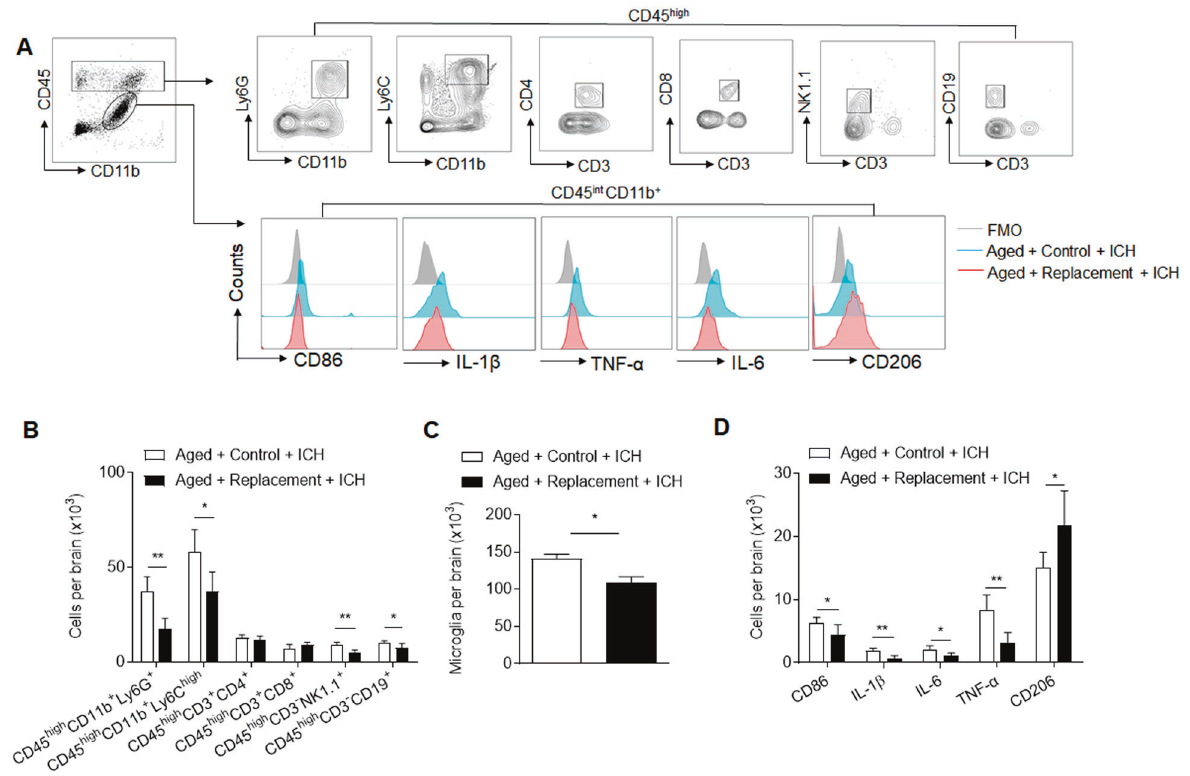
in fi ltrating neutrophils (CD45 high CD11b + Ly6G + ), monocytes (CD45 high CD11b + Ly6C high ), NK cells (CD45 high CD3 - NK1.1 + ), CD4 + T cells (CD45 high CD3 + CD4 + ), CD8 + T cells (CD45 high CD3 + CD8 + ), and B cells (CD45 high CD3 - CD19 + ), as well as microglia (CD11b + CD45 int ) and markers of their in fl ammatory activity (CD86, TNF- α , IL-6, IL-1 β , CD206). B Counts of brain-in fi ltrating leukocyte subsets in the brains from indicated groups of ICH mice. C , D Counts of microglia and their expression CD86, TNF- α , IL-6, IL-1 β , and CD206 in the brains from indicated groups of